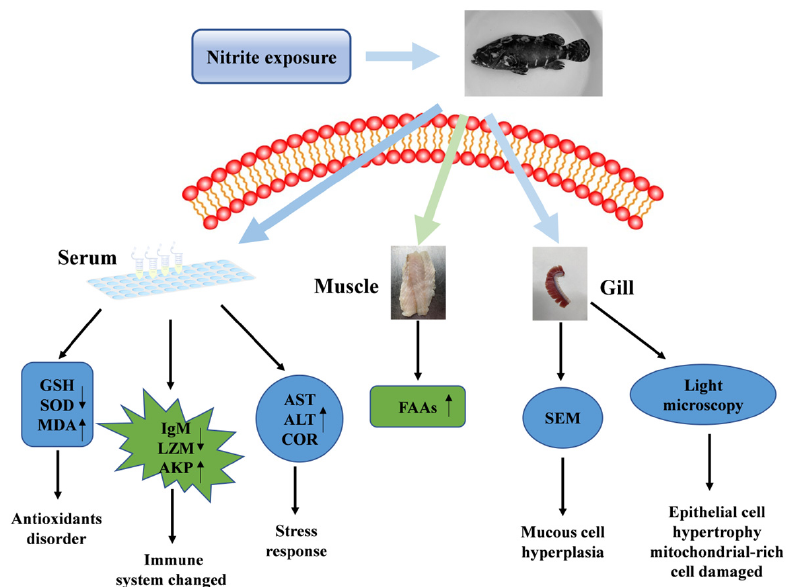
Figure 8. Possible mechanisms of nitrite-induced toxicity of the pearl gentian grouper. ↑ indicates elevated levels of indicators; ↓ indicates decreased levels of